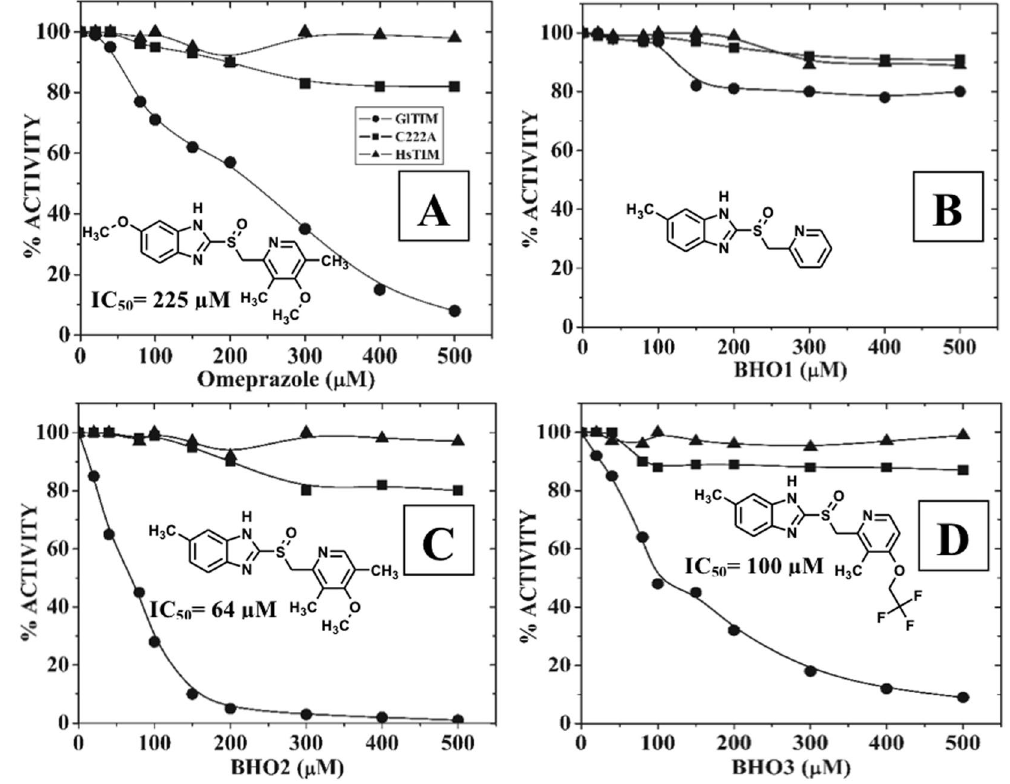
Figure 3. Inactivation assays of GlTIM with the compounds. GlTIM (200 µ g/mL) was incubated with increasing concentrations of compounds. After 2 hours of incubation at 37 °C, the reactions were stopped by dilution and the remaining activity was determined as described in the material and methods section. The IC 50 values from each compound are showed in each panel. The figures show representative experiments performed by